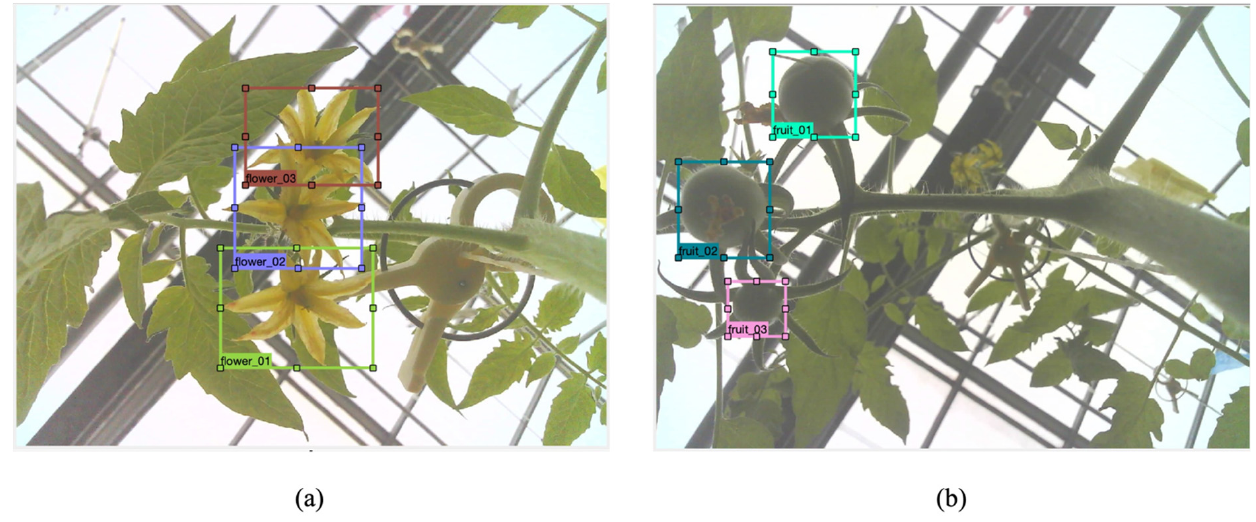
Figure 7. Deep learning-based bloomed flowers and immature fruits detection in tomato. ( a ) Bloomed flower detection; ( b ) Immature fruit detection.